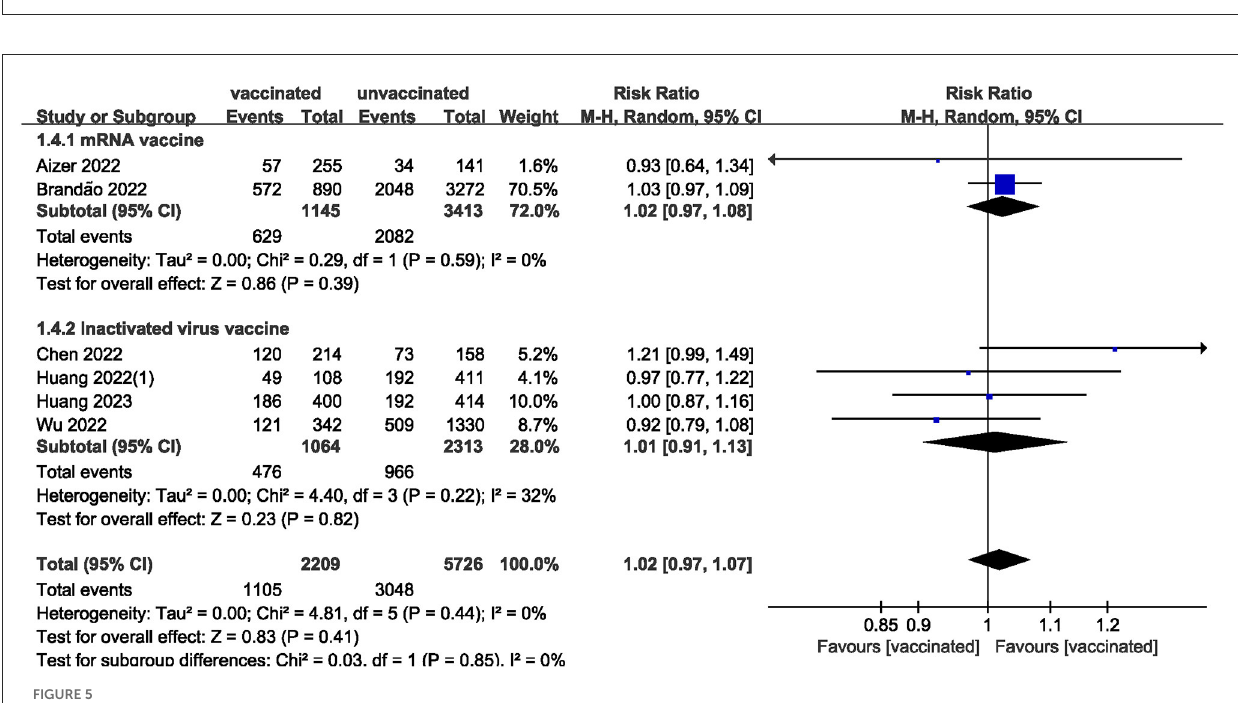
0.844 and 0.053, respectively. However, there was publication bias in the number of oocytes and MII/mature oocytes, with Egger values of 0.010 and 0.036, respectively. The results of the combined effect of the number of oocytes and MII/mature oocytes did not change significantly using the trim and fill method ( P = 0.767; P = 0.403), indicating that the non-significant result was relatively